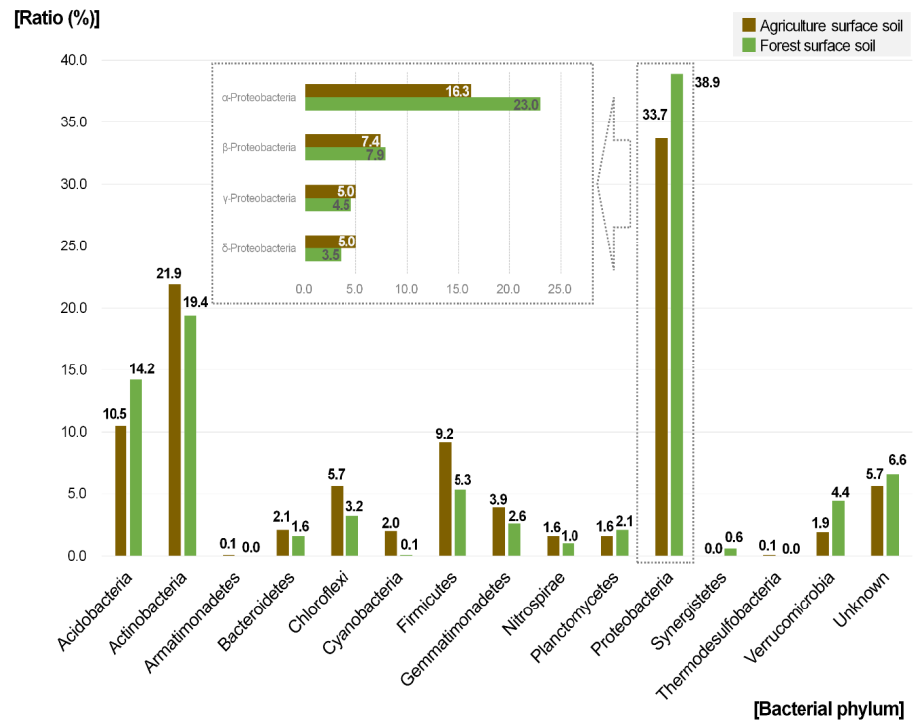
Figure 2. Comparison of bacterial diversity between agricultural and forest land use types at the phylum levels. In agriculture soil, the phyla Cyanobacteria, Nitrospirae, Bacteroidetes, Gemmatimo- nadetes, Firmicutes, and Chloroflexi and class Gammaproteobacteria were relatively dominant. In forest soil, the phyla Synergistetes, Planctomycetes, Verrucomicrobia, and Acidobacteria and class Alphaproteobacteria were relatively dominant. The phylum Pro- teobacteria, which showed a relatively lower level in agriculture soil, and Firmicutes [9.2% with ≥3.9% difference relative to other use (forest 5.3%)], Cyanobacteria [2.0% with ≥1.9% difference relative to other use (forest 0.1%)], Gemmatimonadetes [3.9% with ≥1.3% dif- ference relative to other use (forest 2.6%)], Chloroflexi [5.7% with ≥2.5% difference relative